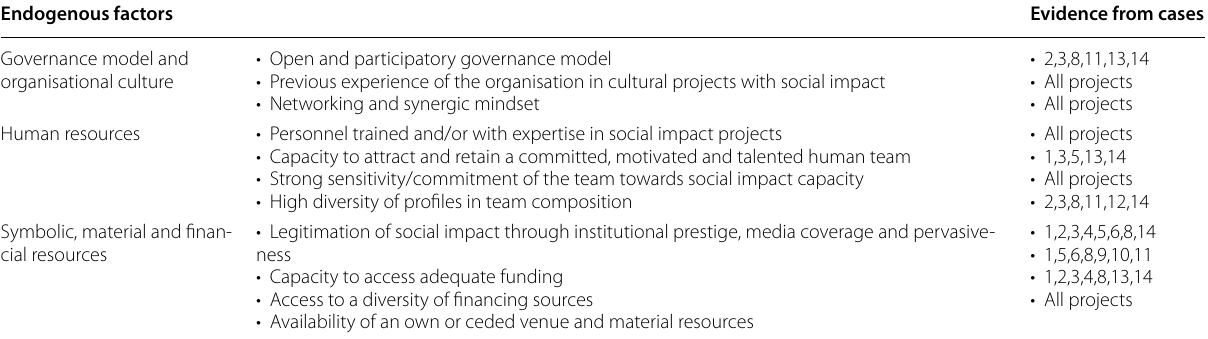
Table 3 Endogenous factors Endogenous factors Evidence from